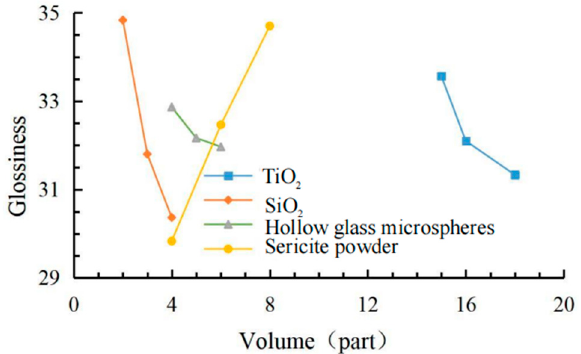
Figure 5. Factor effect of cooling value.